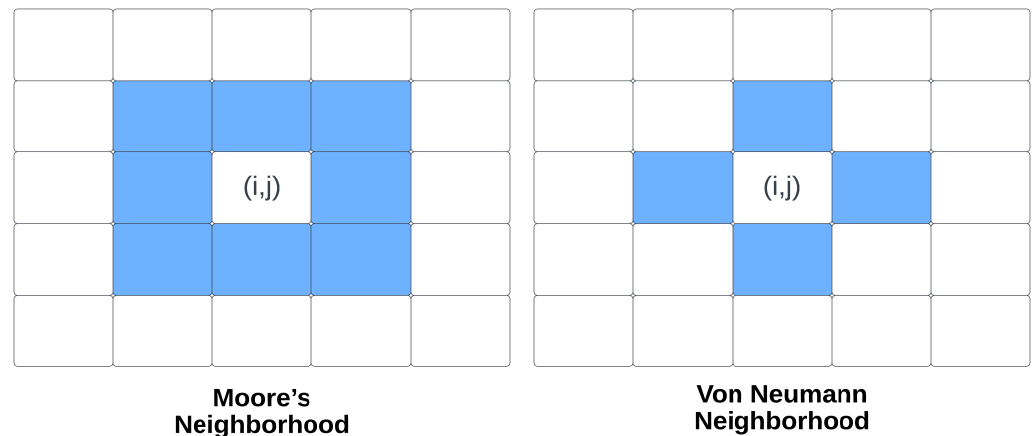
Figure 1. Illustration of Moore’s and Von Neumann neighborhood schemes at radius 1 .